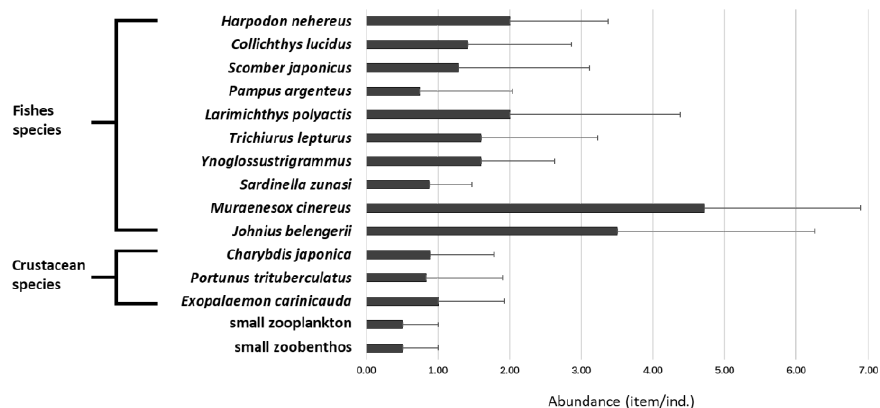
Figure 2. Average abundance of microplastics (±SD) in the gastrointestinal tracts of fish and crusta- ceans and the body of zooplankton and zoobenthos from the Zhoushan fishing ground.